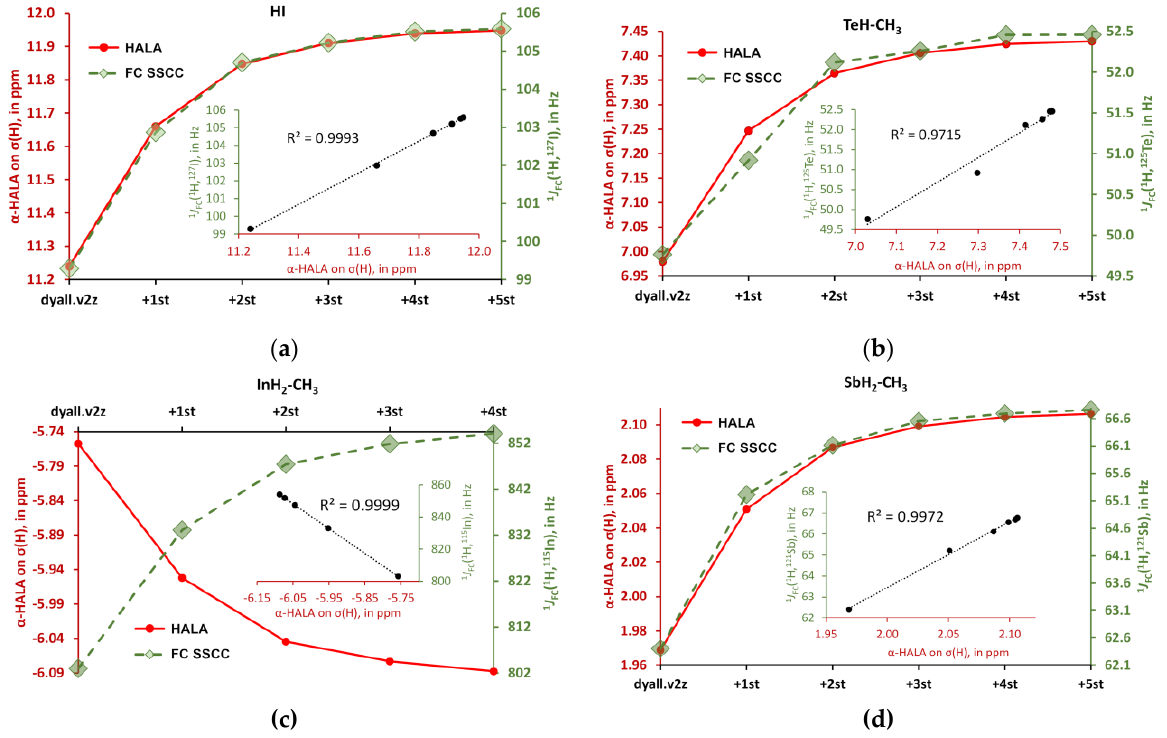
Figure 8. The behaviors of the α -HALA effects on σ ( 1 H) upon the saturation of the dyall.v2z basis set on protons in the tight s -region against that of the 1 J FC (HA, 1 H) in molecules: ( a ) HI ( 1 ); ( b ) TeH-CH 3 ( 6 ); ( c ) InH 2 -CH 3 ( 4 ); and ( d ) SbH 2 -CH 3 ( 3 ).